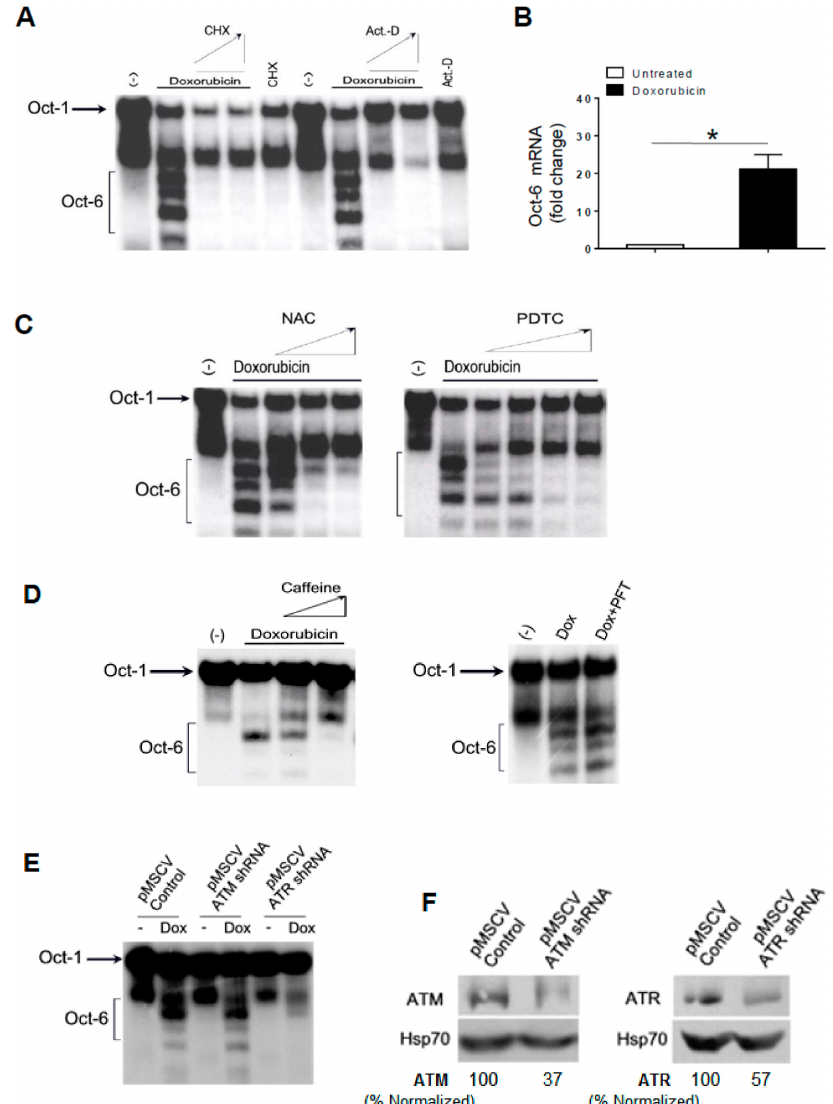
Figure 2. Doxorubicin induces Oct-6 in H460 cells: role of reactive oxygen species (ROS) and ataxia telangiectasia mutated- and Rad3-related (ATR). EMSA was performed, as described above, from H460 cells unstimulated ( − ) or treated with Dox for 24 h, in the absence or in the presence of di ff erent concentrations of 5 and 10 µ g / mL of cycloheximide (CHX), or 1 and 5 µ g / mL of actinomycin D (Act-D) ( A ), or N-acetylcysteine (NAC;10, 30, and 60 mM), or pyrrolidine dithiocarbamate (PDTC; 100, 200, 300, and 500 µ M) ( C ), or ca ff eine (1 and 2.5 µ M), or pifithrin- α (PFT; 30 µ M) ( D ). The data are representative of one out of two independent experiments. ( B ) Real-time PCR analysis of the total mRNA obtained from H460 cells, untreated or treated with Dox (0.5 µ M) for 24 h. The data, expressed as fold change units, were normalized with glyceraldehyde 3-phosphate dehydrogenase (GAPDH), and were referred to the untreated cells, considered as a calibrator, and represent the mean of three experiments (* p < 0.05). ( E ) EMSA was performed, as described above, in the presence of nuclear extracts (10 µ g) from shRNA-ATM or ATR retrovirus infected H460 cells, unstimulated ( − ) or treated with Dox for 24 h. The data are representative of one out of two independent experiments. ( F ) Immunoblotting analysis for ataxia telangiectasia mutated (ATM) or ATR and Hsp70 of the total cellular proteins obtained from H460 cells infected with the empty control retrovirus (pMSCV control), or the retrovirus expressing ATM (pMSCV-ATM) or ATR (pMSCV-ATR) shRNA. The data are representative of one out of three independent experiments. The densitometric analysis of normalized ATM / Hsp70 and ATR / Hsp70 is shown (the whole blots are shown in the Supplementary